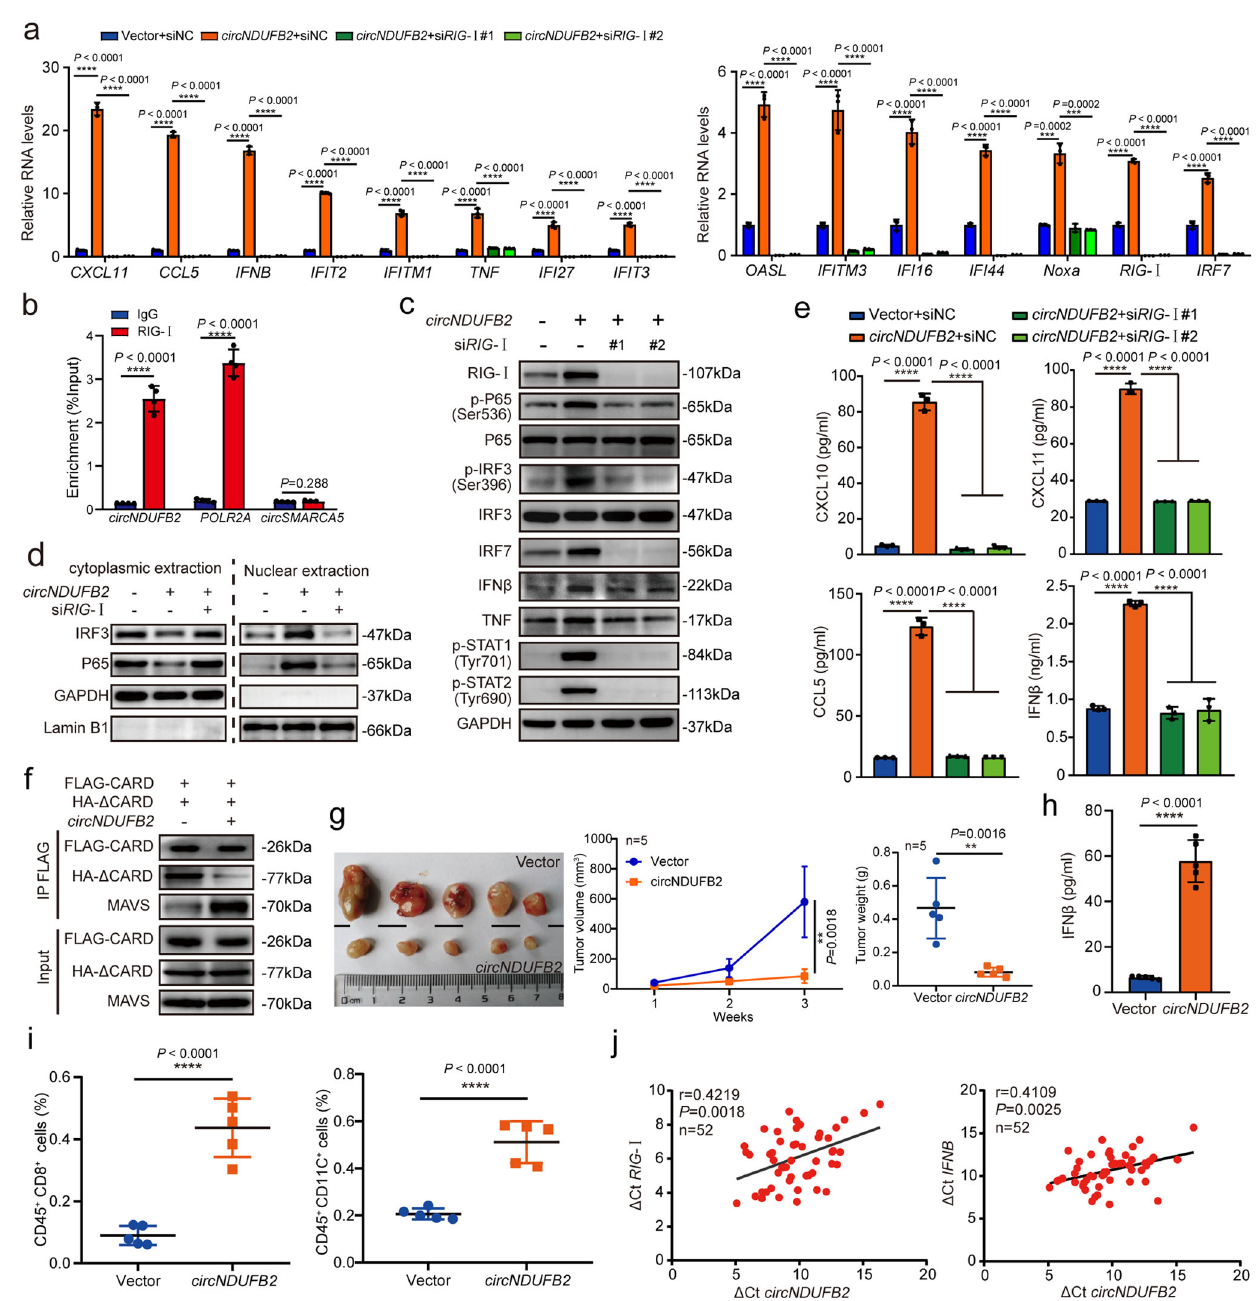
Fig 6 circNDUFB2 activates downstream signaling of RIG-I. a Fold change of indicated mRNAs in A549 cells with or without RIG-I knockdown. n = 3 biologically independent samples. b Analysis for circNDUFB2 enrichment. RIP assay was performed using RIG-I antibody in A549 cells. POLR2A was used as a positive control and circSMARCA5 was used as a negative control. n = 4 biologically independent samples. c Protein levels in A549 cells with circNDUFB2 overexpression or RIG-I knockdown. d Protein levels of IRF3 and P65 in the nuclear and cytoplasmic fractions in the indicated cells. e Levels of CXCL10, CXCL11, CCL5, and IFN β in the supernatants of A549 cells with circNDUFB2 overexpression or RIG-I knockdown. n = 3 biologically independent samples. f Interactions between CARDs of RIG-I with helicase domain of RIG-I and MAVS in A549 cells. FLAG-CARD, CARDs of RIG-I with FLAG-tagged; HA- Δ CARD, helicase and CTD of RIG-I with HA-tagged. g The volume and weight of subcutaneous xenograft tumors ( n = 5 mice per group). h Levels of IFN β in the serum of mice ( n = 5 mice per group). i The percentage of CD8 + T cells and DCs in subcutaneous xenograft tumors. n = 5 tumors per group. j Correlation analysis for circNDUFB2 and RIG-I or IFN β in the tumorous tissues of 52 NSCLC patients. Δ Ct values were normalized according to GAPDH . n = 52 biologically independent NSCLC tissues. R represents the Pearson correlation coef fi cient. Data are presented as mean ± s.d. P values are calculated by unpaired two-sided t -test in a , b , e , g – i . P values in j are calculated by F -test. Two independent experiments were carried out with similar results in c , d , f